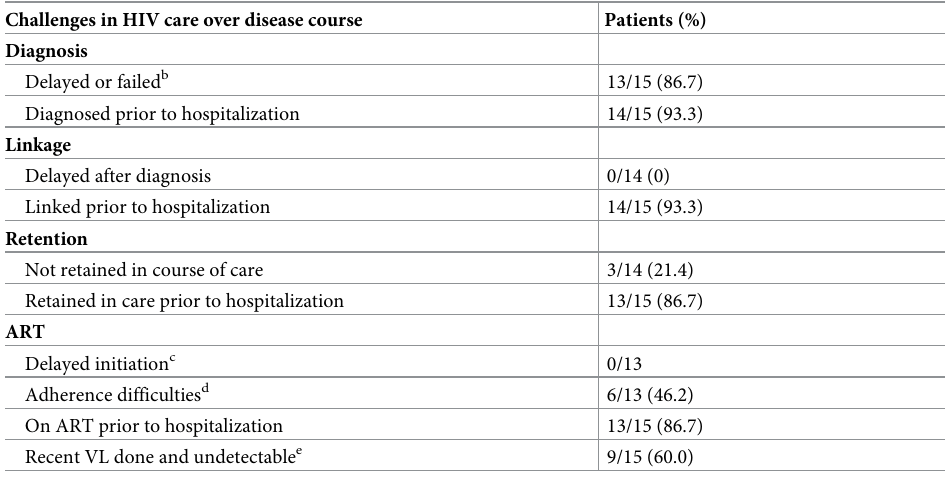
Table 3. Missed opportunities in the HIV care cascade a